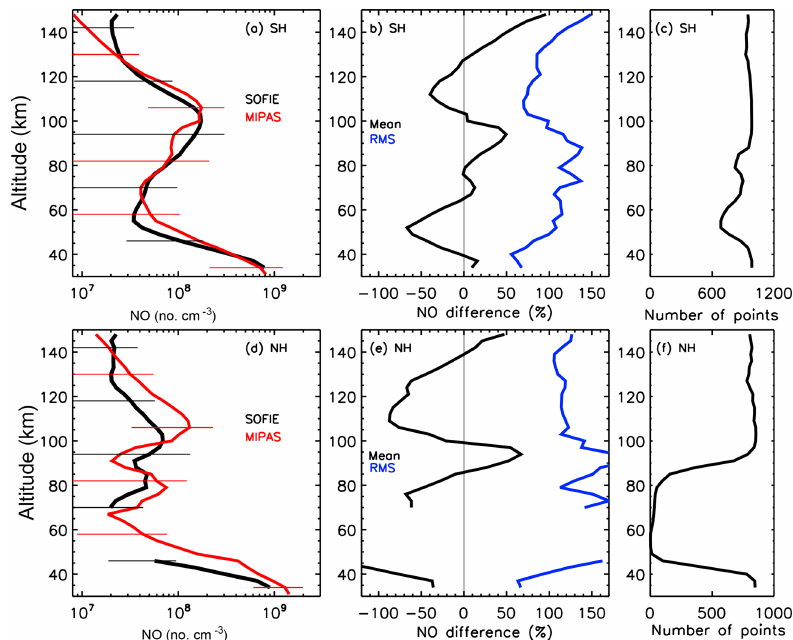
Figure 8. Comparison of SOFIE and MIPAS NO vertical profiles, for the coincidences shown in Fig. 6. Comparisons in the SH (SOFIE spacecraft sunset; local sunrise) as (a) average profiles, (b) mean and rms differences, and (c) number of points in the comparison at each altitude. Comparisons in the NH (SOFIE sunrise) as (d) average profiles, (e) mean and rms differences, and (f) number of points in the comparison. Mean NO and NO differences are only shown when there were more than 30 points in the comparison. Horizontal lines on the average profiles indicate standard deviations.